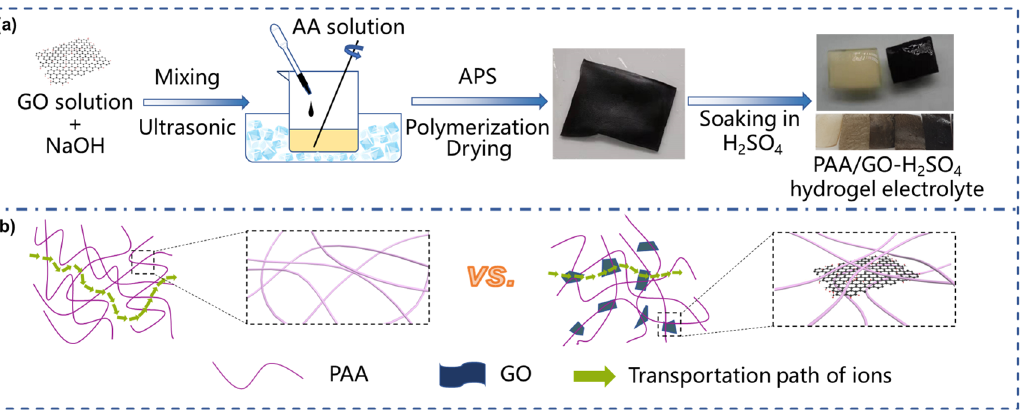
Figure 1. ( a ) Preparation process of PAA/GO composite gel electrolyte and ( b ) the schematic dia ‐ gram for the role of GO in PAA/GO composite gel electrolyte.